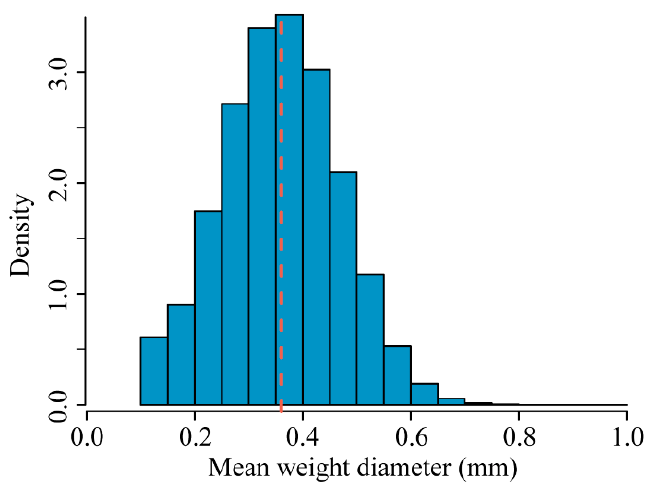
Figure 6. Histogram of the predicted soil mean weight diameter (MWD) across the entire study region. The vertical dashed line in red represents the mean MWD.